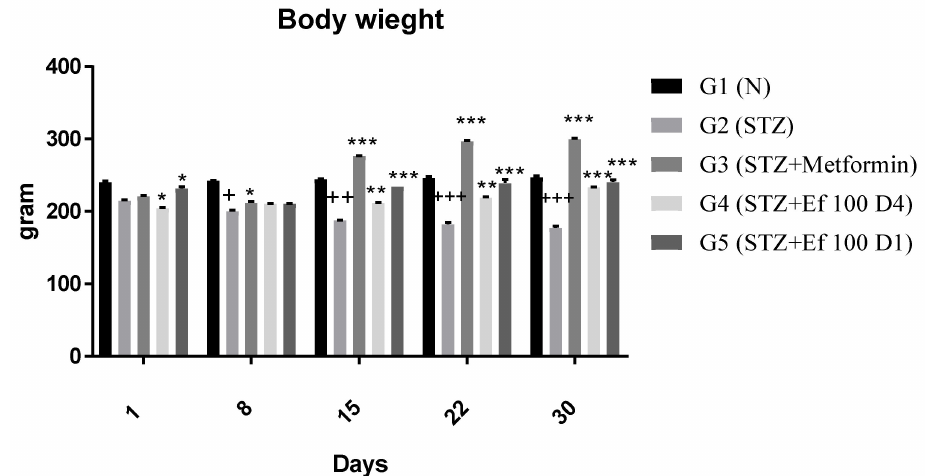
Figure 3. Effects of different treatments on body weight (g) of different experimental groups. Day 1: the day of the STZ injection, G1: normal, nondiabetic rats treated with normal saline solution orally, G2: diabetic rats treated with normal saline solution orally, G3: diabetic rats treated with metformin (100 mg/Kg) orally starting from Day 4, G4: diabetic rats treated with Ephedra foeminea extract (100 g/kg) orally starting from Day 4, G5: diabetic rats treated with Ephedra foeminea extract (100 g/kg) orally from Days 1 to 4. Bars represent the mean of the body weight ± SD of 6 rats. From Day 15, body weights were significantly (*** indicates p < 0.0001) increased for diabetic rats treated with metformin (G3) and Ephedra foeminea extract (G4 and G5) compared to the untreated induced diabetic rats (G2). The results are expressed as means ± SD ( n = 3–4 dependent replicates). *: p < 0.05, **: p < 0.01, ***: p < 0.001 compared to G2: diabetic rats. +: p < 0.05, ++: p < 0.01, +++: p < 0.001 compared G1: nondiabetic rats. The result were analyzed using one way